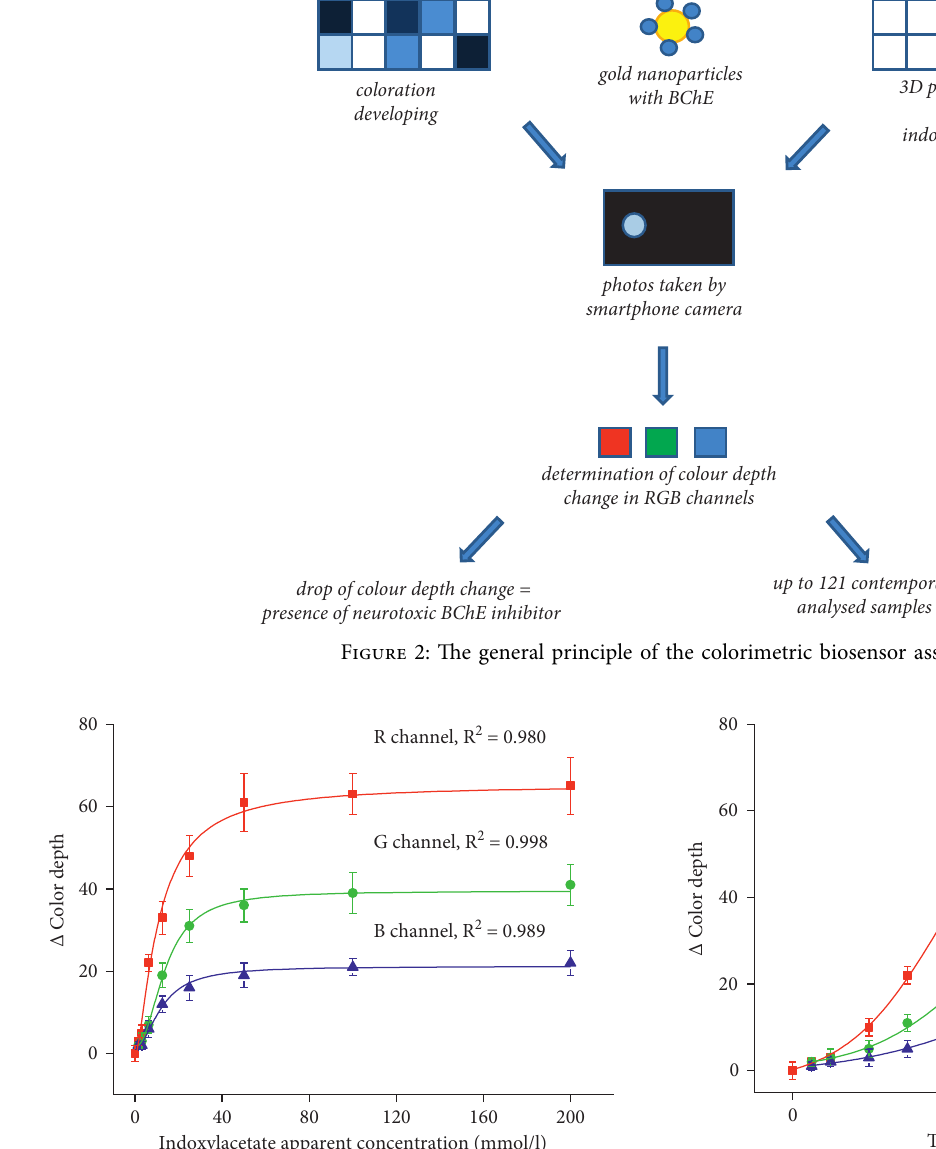
Figure 3: Saturation curves were received for indoxylacetate when deionized water was used as a sample for the biosensor perfor- mance. The concentration of indoxylacetate is an apparent one. The error bars indicate the standard error for five independent repeats ( n � 5).